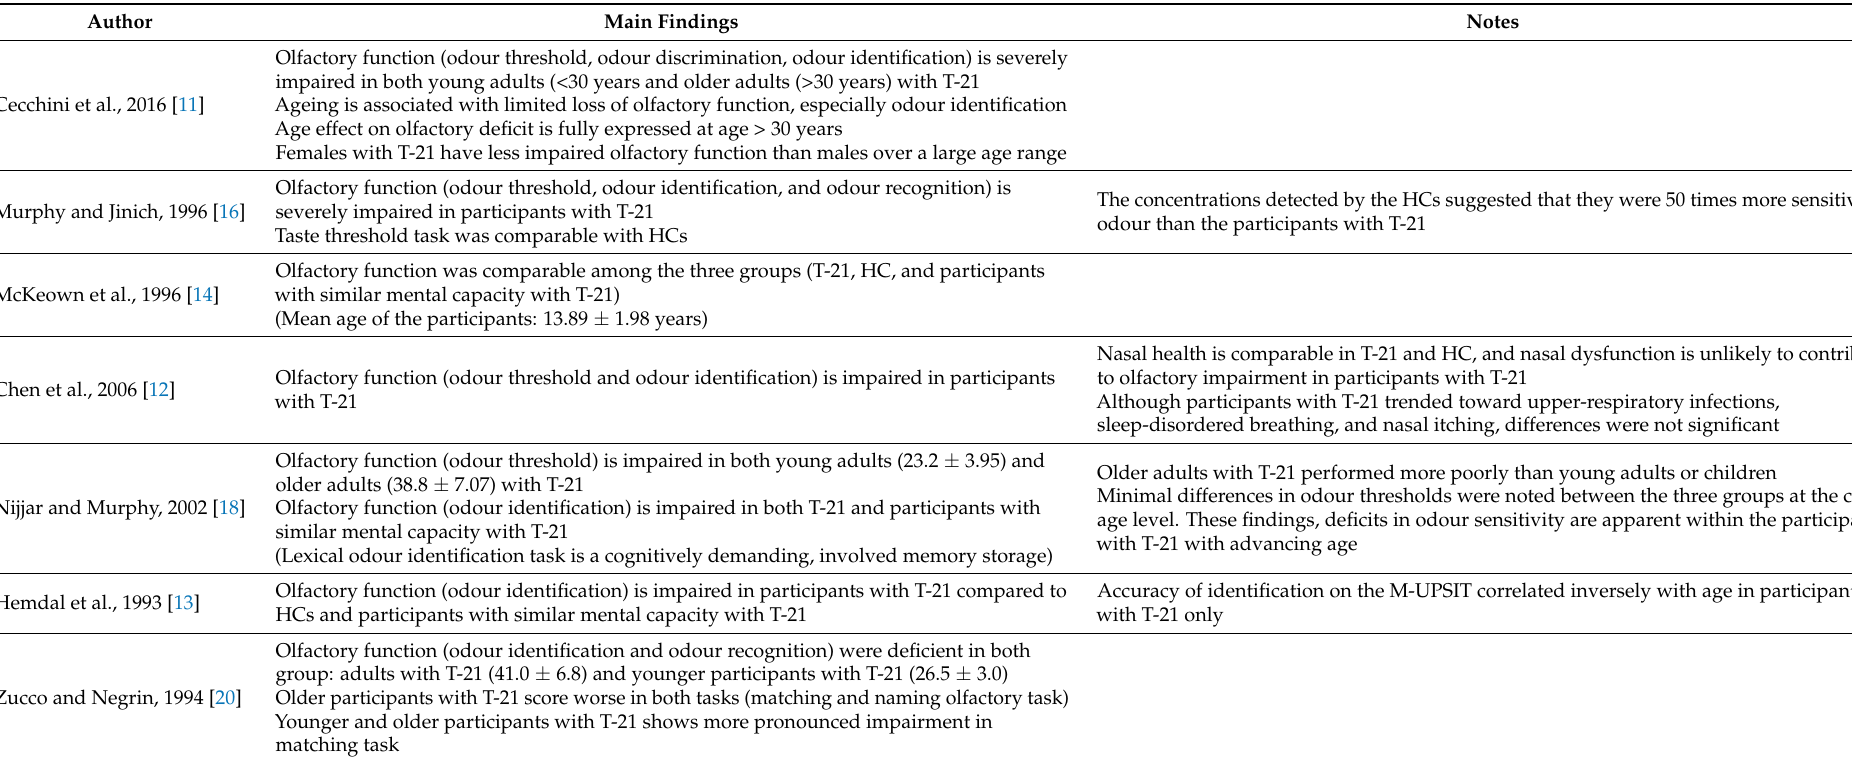
Table 3. Summary of the olfactory function in an individual with trisomy